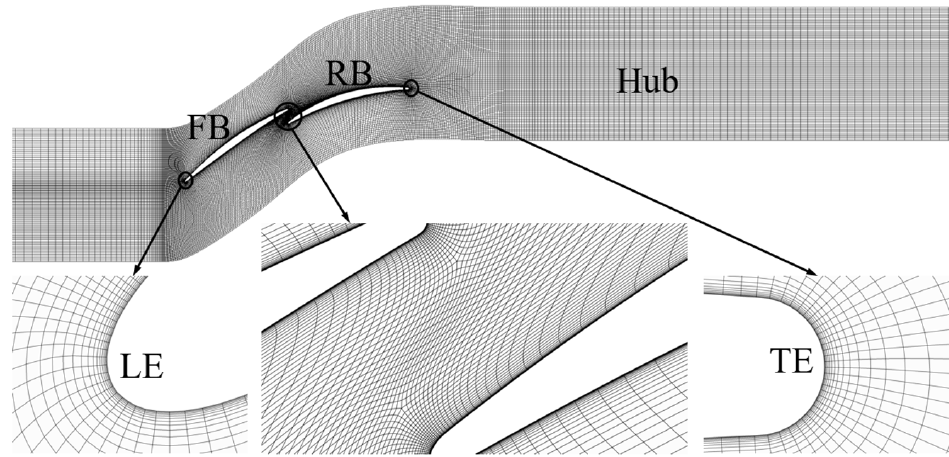
Figure 5. The endwall meshes of the tandem cascade.